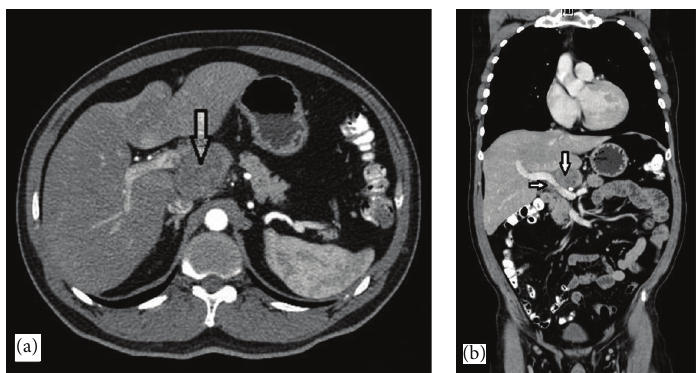
Figure 1: Transverse (a) and coronal (b) images of contrast enhanced CT showing upper abdominal mass located at liver hilum, containing heterogenous lymphadenopathy (arrows).